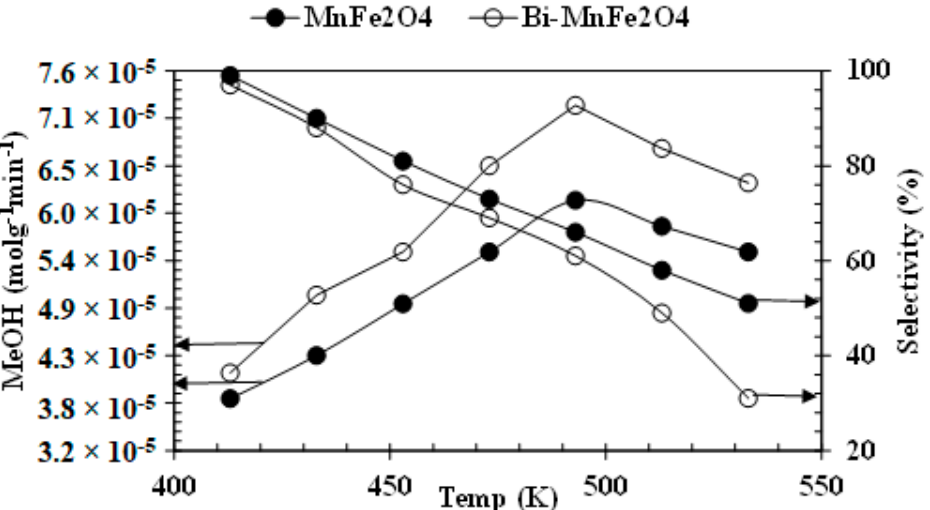
Figure 4. Effect of temperature on the rate of MeOH production and selectivity. Reaction conditions: pressure: 1 bar, GHSV: 22,000 h − 1 , data collected after 90 min, feed ratio: 3/1 H 2 /CO 2 .